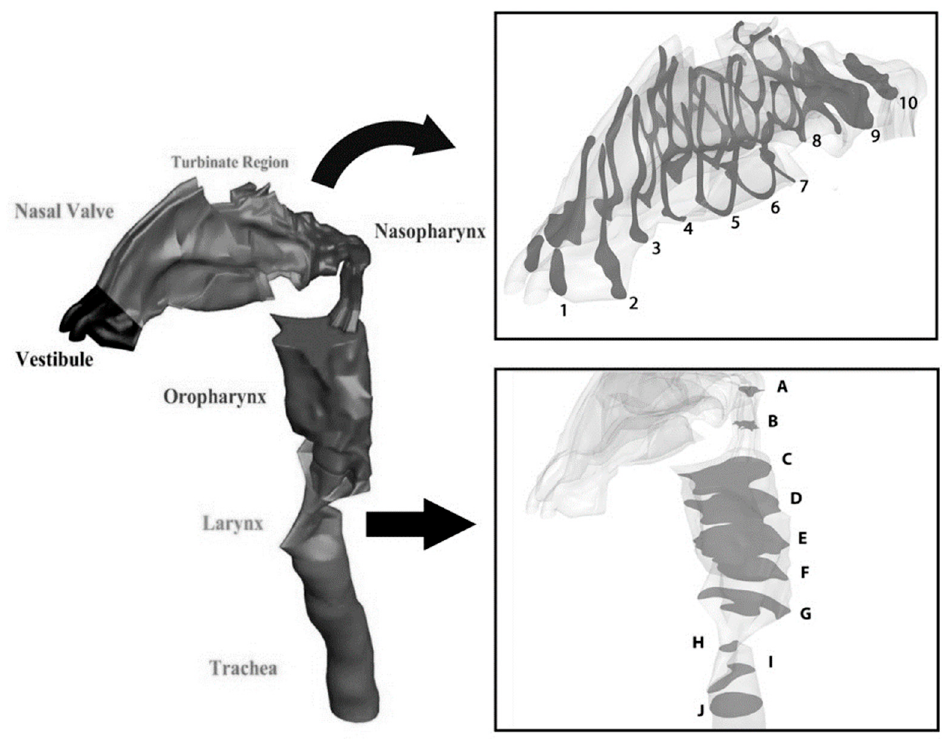
Figure 2. Three-dimensional view of the upper airway geometry, showing different regions.